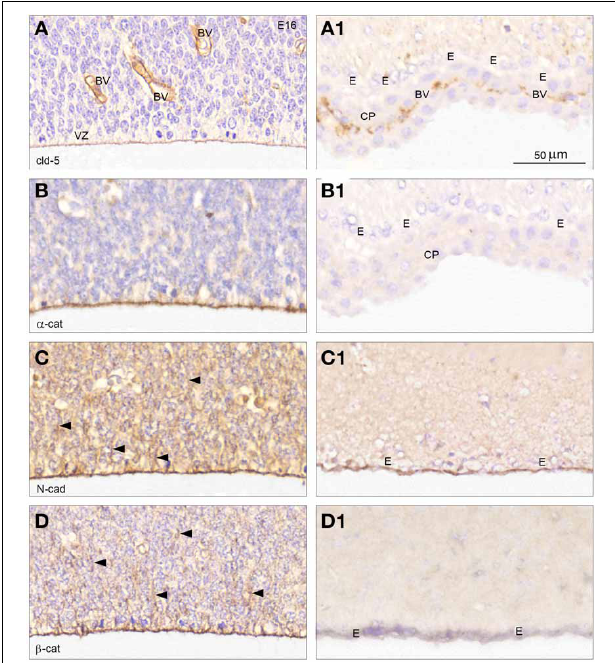
FIGURE 7 | Cellular distribution of adherens and tight junctional proteins at the lateral CSF-brain interface. High magnification coronal sections of E16 (A–D) from boxed areas in Figure 6 and of adult (A1–C1) and P20 (D1) forebrain immunostained for claudin-5 (A,A1) , α -catenin (B,B1) , N-cadherin (C,C1) , and for β –catenin (D,D1) . (A) At E16 claudin-5 reactivity is prominent in endothelial cells of blood vessels (BV), but a distinct staining is also present corresponding to the apical-most part of the ventricular zone cells (VZ). (A1) In the adult forebrain ependymal cells (E) show no claudin-5 immunoreactivity in marked contrast to the positively stained endothelial cells of fenestrated blood vessels of the choroid plexus (CP). (B–D) At E16 immunostaining for α -catenin (B) , N-cadherin (C) and β -catenin (D) outlines the apical and apico-lateral most part of the ventricular zone cells,—compare (A) (apical) and (D) (apical and apico-lateral staining). N-cadherin and β -catenin immunostaining extends into the cytoplasm of the ventricular zone cells ( arrowheads in C,D ). (B1) Immunoreactivity for α -catenin is not present in adult forebrain, neither in ependymal cells (E) nor in the choroid plexus (CHP). (C1,D1) The surface of the ependymal cells (E) is strongly stained for N-cadherin but only little reactivity is observed after staining for β -catenin in the adult forebrain and virtually no reactivity is observed in the subependymal zone. Same magnification in (A–D) and (A1–D1) . Scale bar 50 μ m.